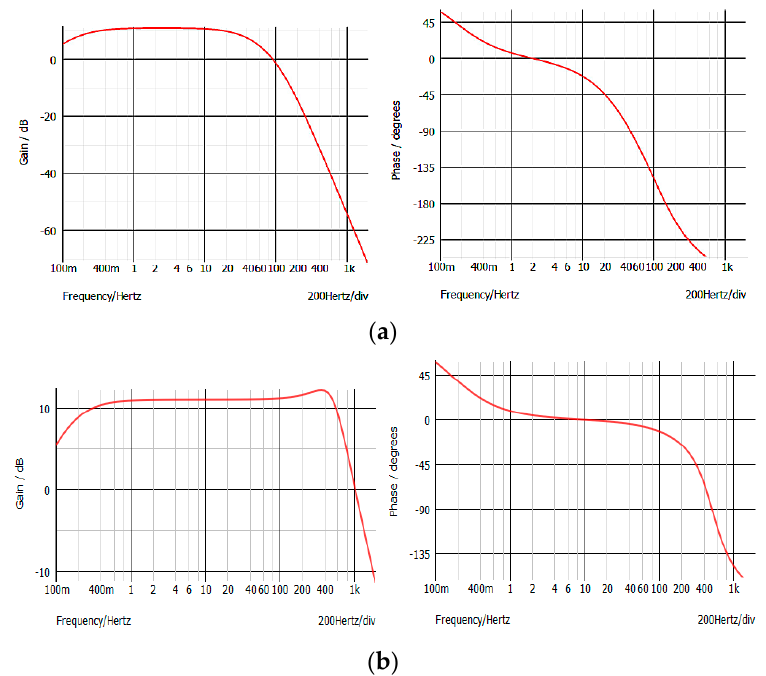
Figure 3. ( a ) Bode plot of original Olimex ECG/EMG shield amplifier (as computed with SIMetrix). ( b ) Bode plot of MODIFIED Olimex ECG/EMG shield amplifier, where a much wider bandwidth is obtained, and this is suitable for EMG recording.